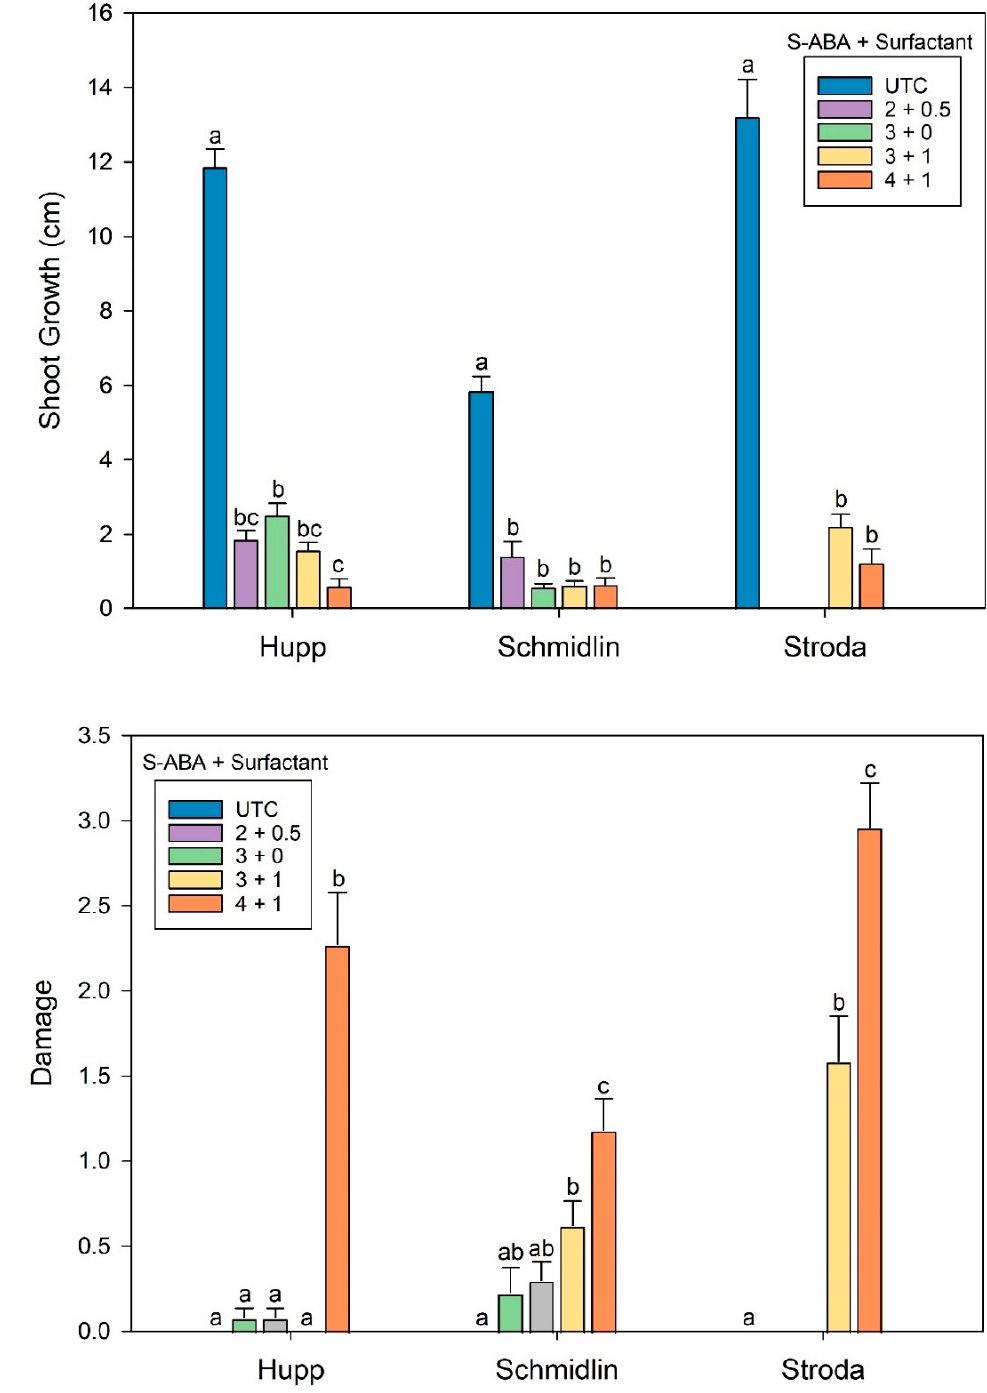
Figure 5. Mean shoot growth ( top ) and damage rating ( bottom ) of leaders of Turkish fir trees at three farms treated in 2019 with S-ABA with and without a surfactant. S-ABA concentration is in % a.i.; surfactant in mL L − 1 . NOTE: Error bars indicate standard error of the mean. Means within a farm indicated by the same letter are not different at p = 0.05. Mean separation by Tukey’s HSD test. Damage rating (0 = no phytotoxicity; 4 = severe phytotoxic damage).